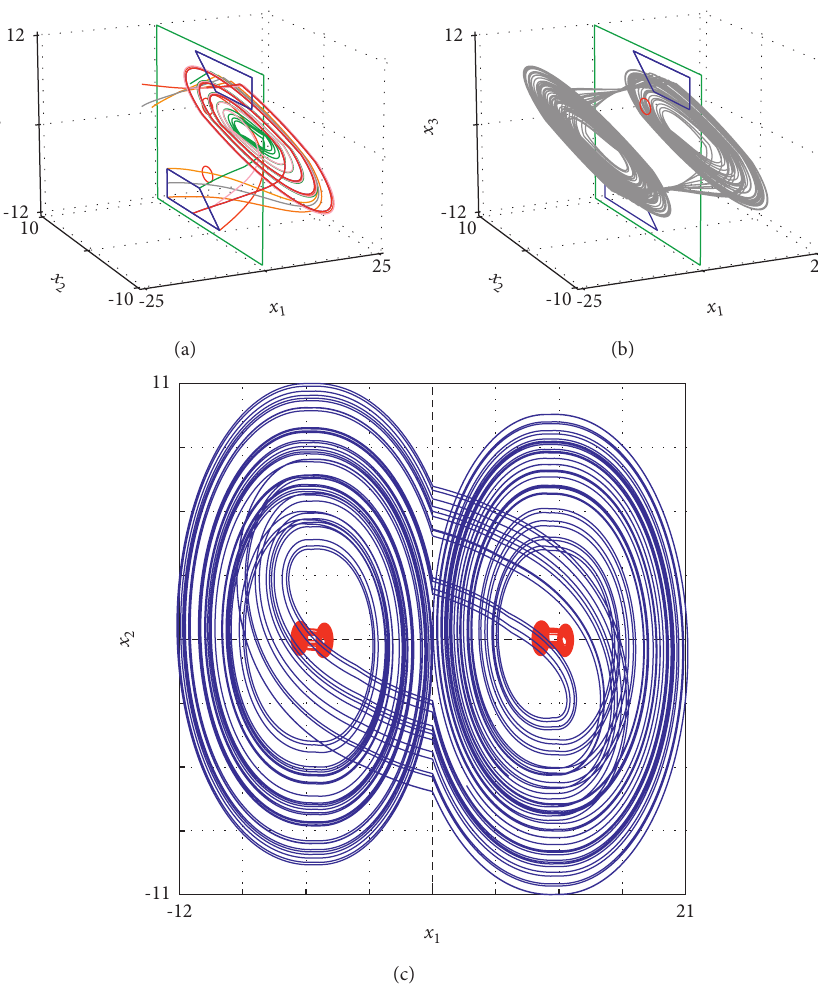
Figure 12: In (a), seven trajectories of the system given by (1), (3), (5), (13), and (90) starting in R c � 10. In (b), hidden attractor for the same parameters and the initial condition x of the self-excited attractors and the hidden attractor onto the plane x